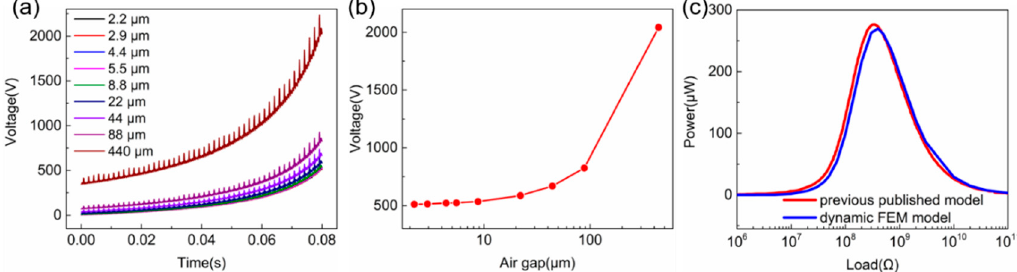
Figure 7. ( a ) The simulated voltage output and ( b ) summarized peak voltage under a 100-G Ω external load. ( c ) The comparison of calculated results based on dynamic FEM model and previous published model, demonstrating excellent consistency.